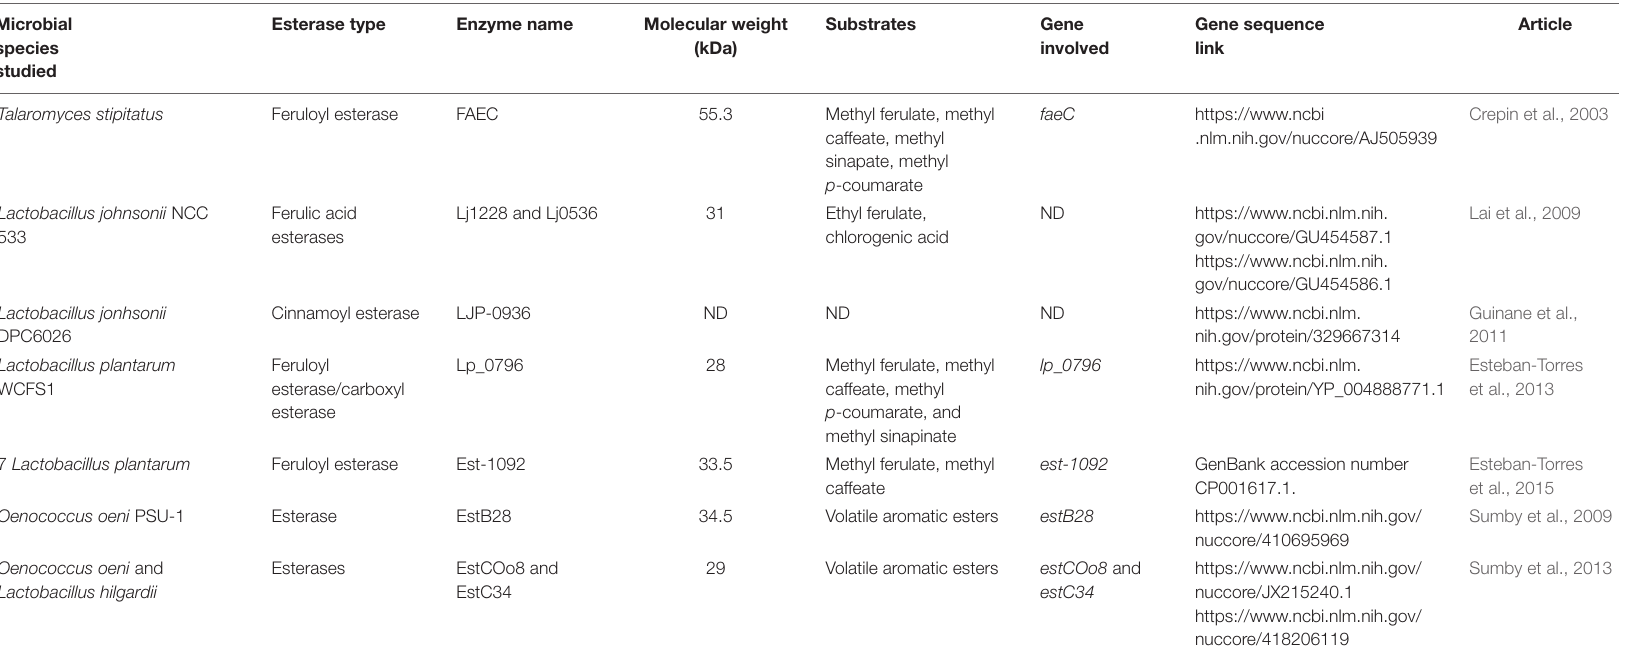
TABLE 2 | Putative esterases from the literature. Microbial